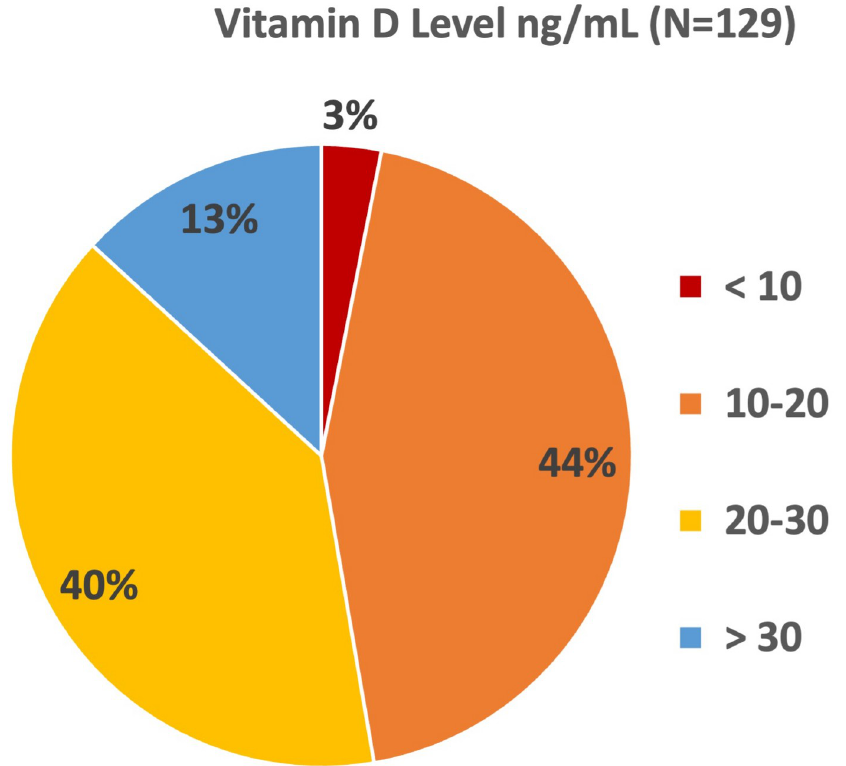
Fig 4. Serum 25-OH Vitamin D levels around diagnosis. Vitamin D deficiency and insufficiency rates are high in this cohort.